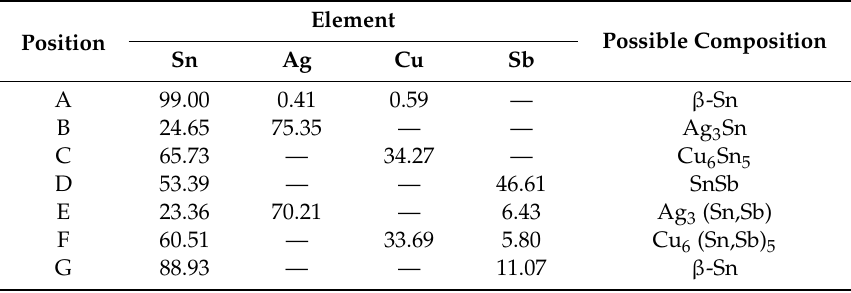
Table 2. Energy spectrometer (EDS) analysis results of marked points